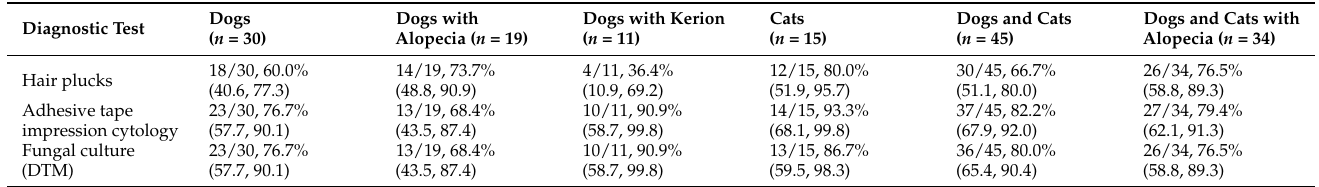
Table 3. Sensitivity of each diagnostic test with the corresponding 95% confidence interval (C.I.) within different dogs’ groups (NA = Not